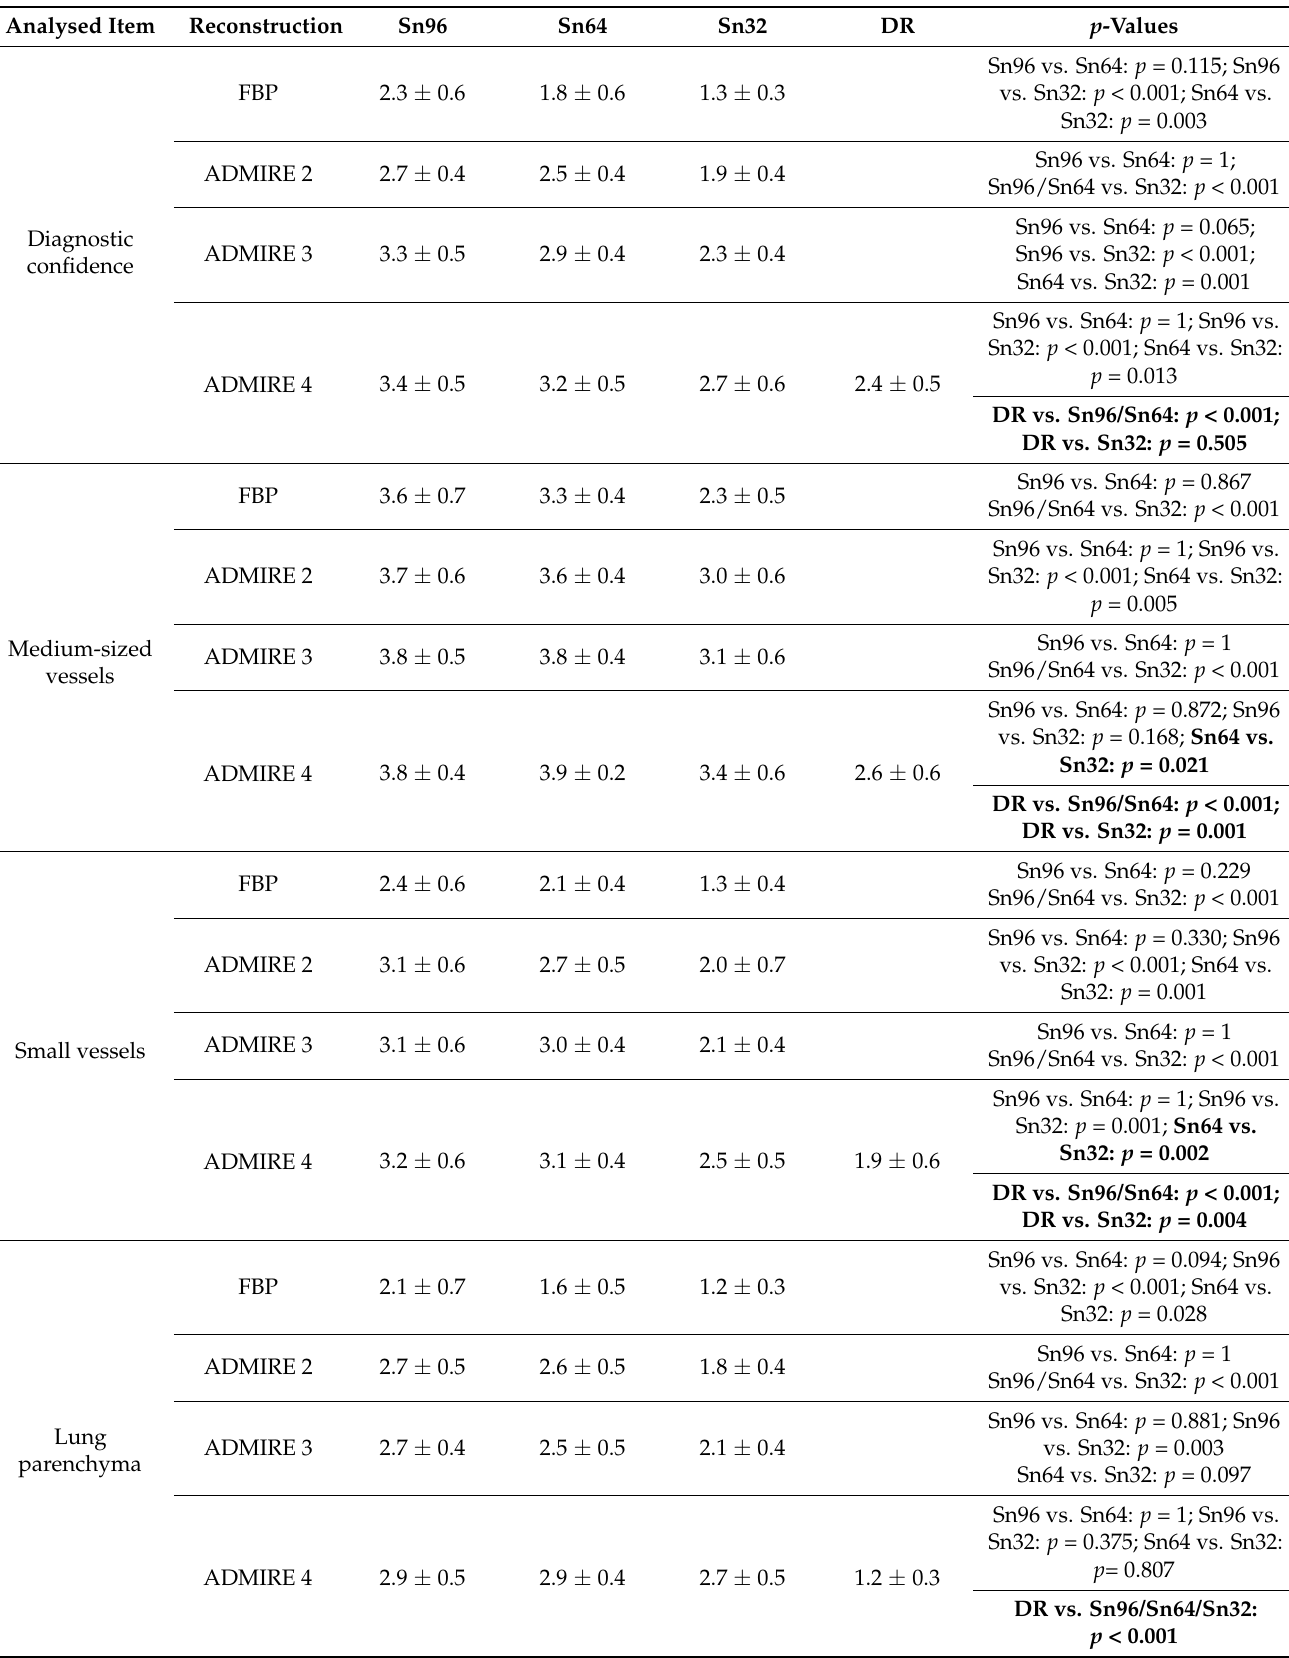
Table 2. Diagnostic confidence and anatomical